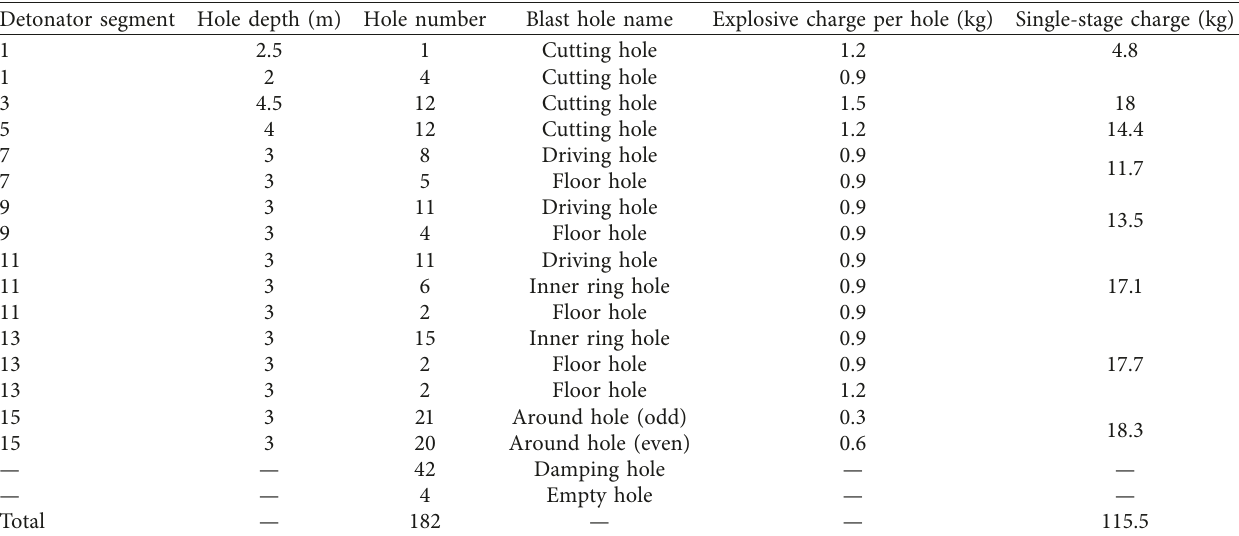
Figure 11: Layout of the blast hole of the upper step after optimization design. Note: the number in the figure is the detonator segment. Table 3: Parameters of the upper step after